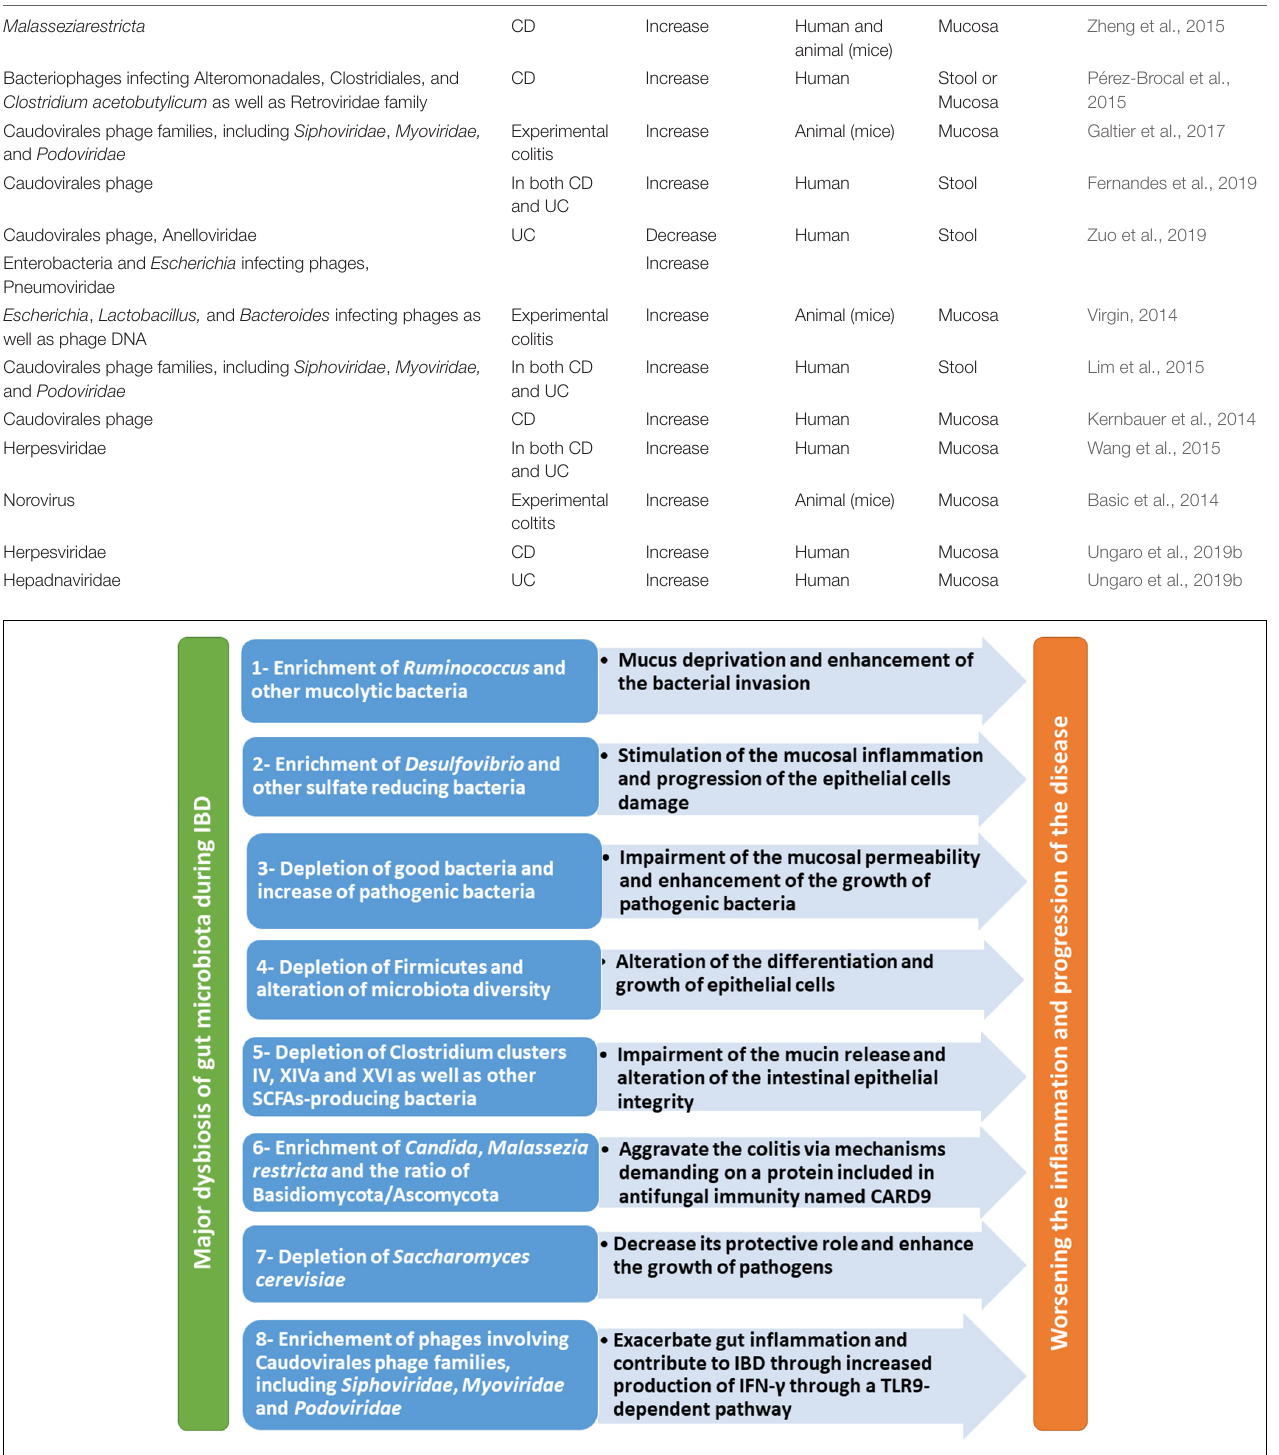
FIGURE 1 | Major dysbiosis of gut microbiome during IBD and its impact on worsening the condition and progression of the disease.